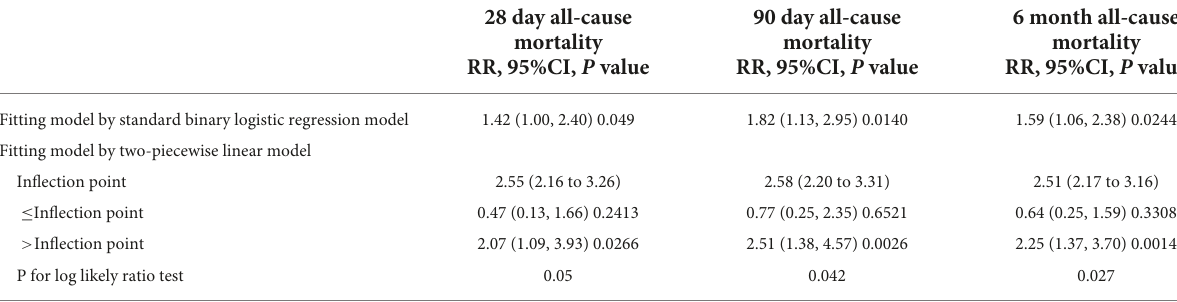
TABLE 3 Exploration of non-linear association between cystatin and all-cause mortality using two-piecewise lienar